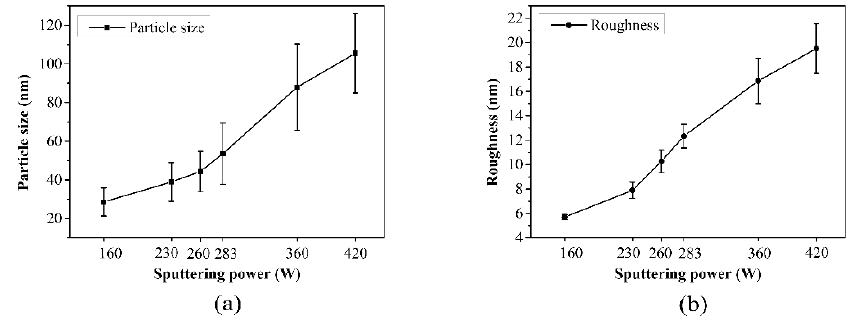
Figure 6. The particle size ( a ) and RMS of surface roughness ( b ) of iron films at different sputtering powers.